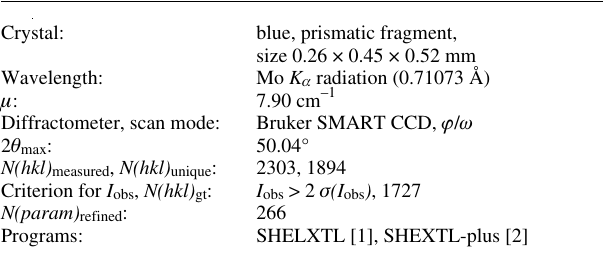
Table 1. Data collection and